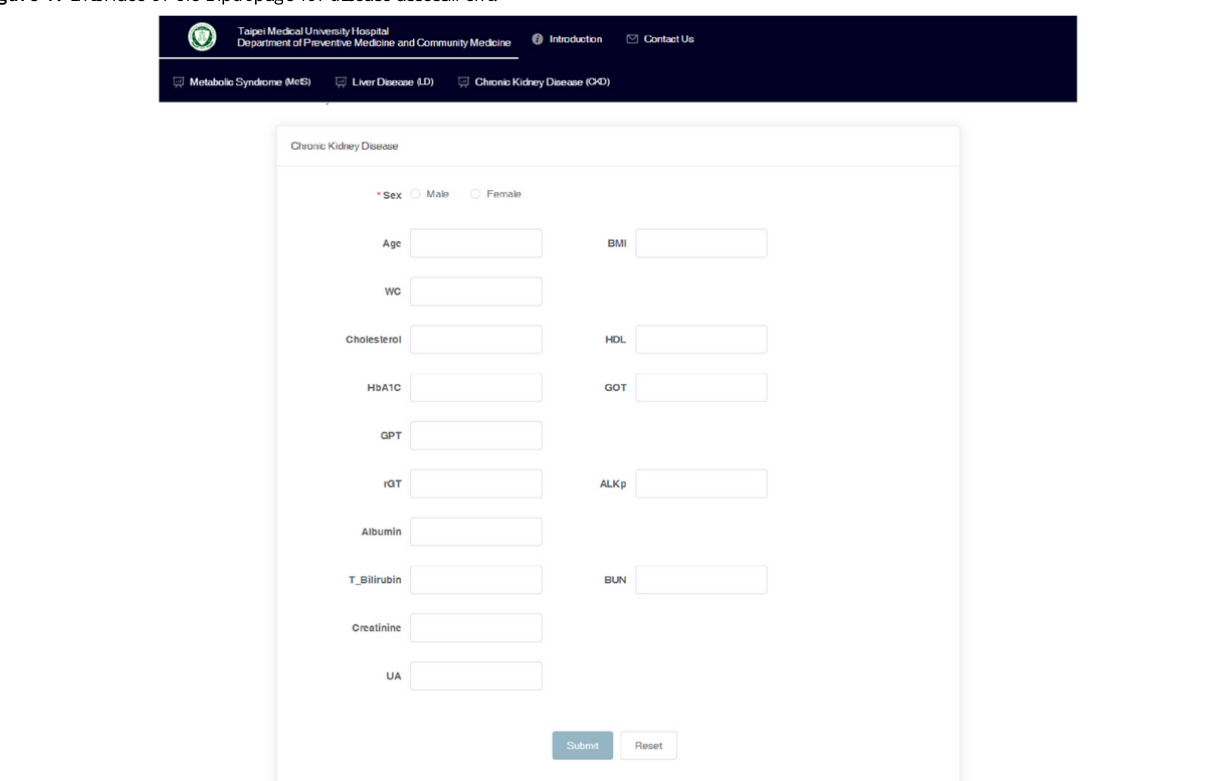
Figure 4. Interface of the input page for disease